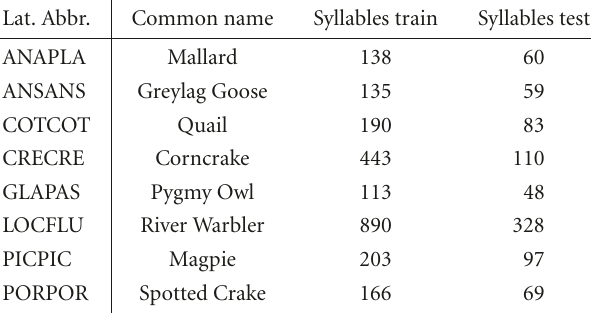
Table 3: 2nd set of bird species studied in this work. The last two columns indicate the number of syllables in training and testing datasets,